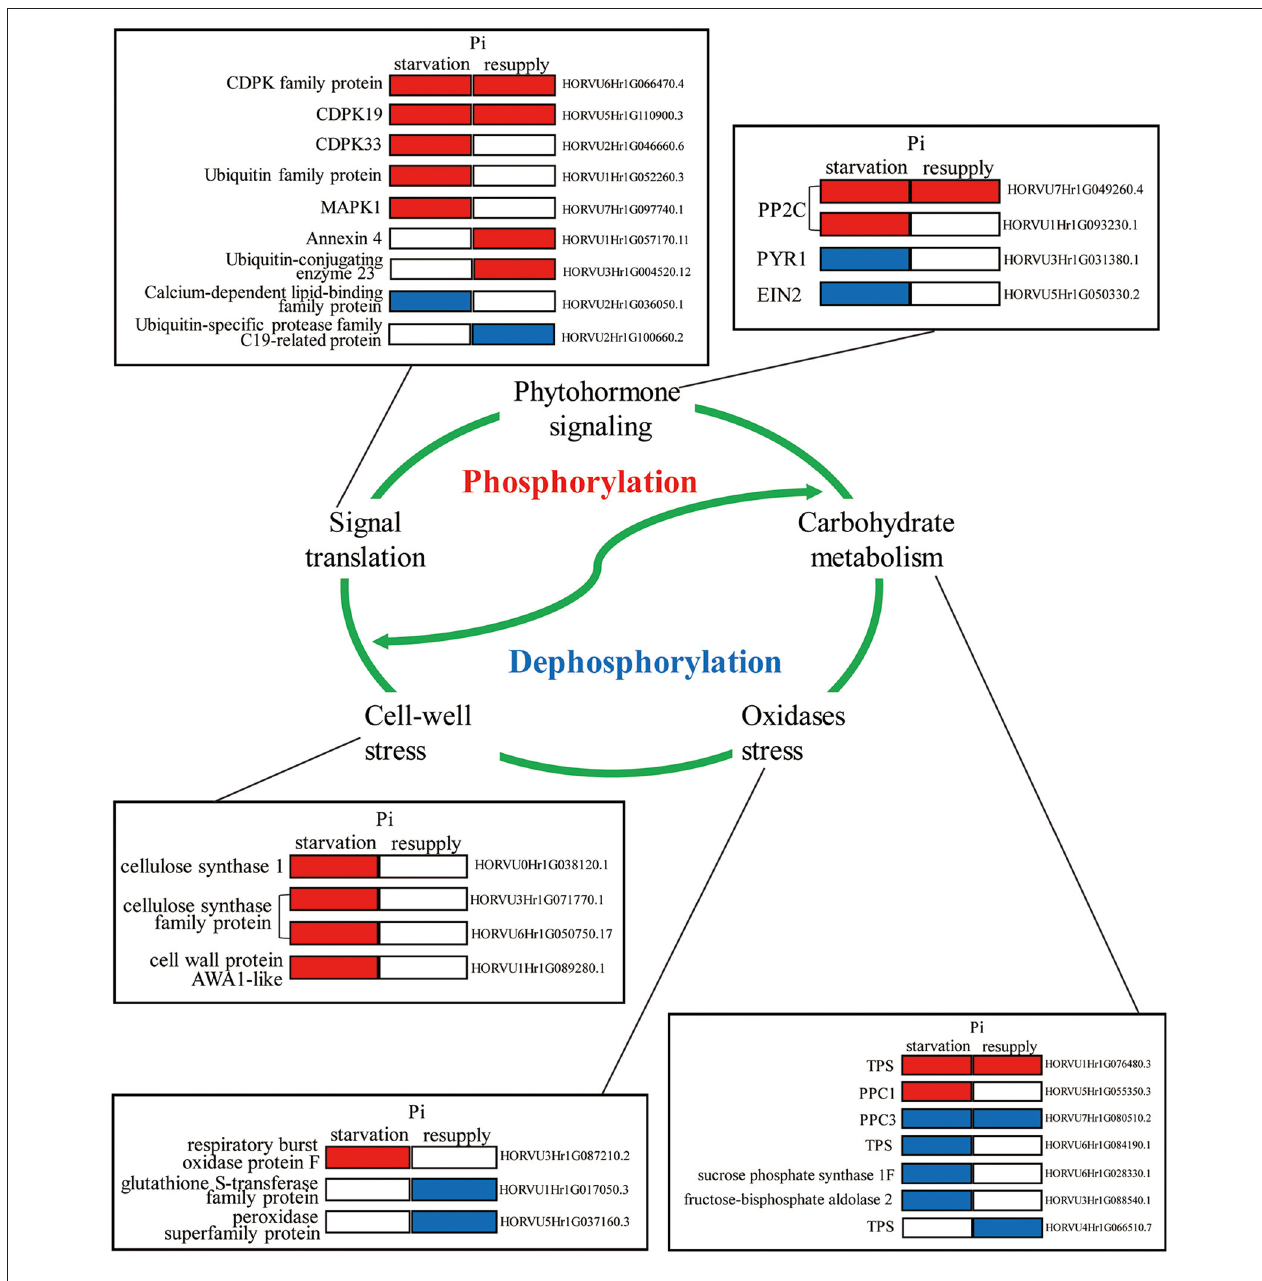
FIGURE 9 | Molecular model of the underlying phosphorylation mechanisms involved in Pi starvation/resupply in barley